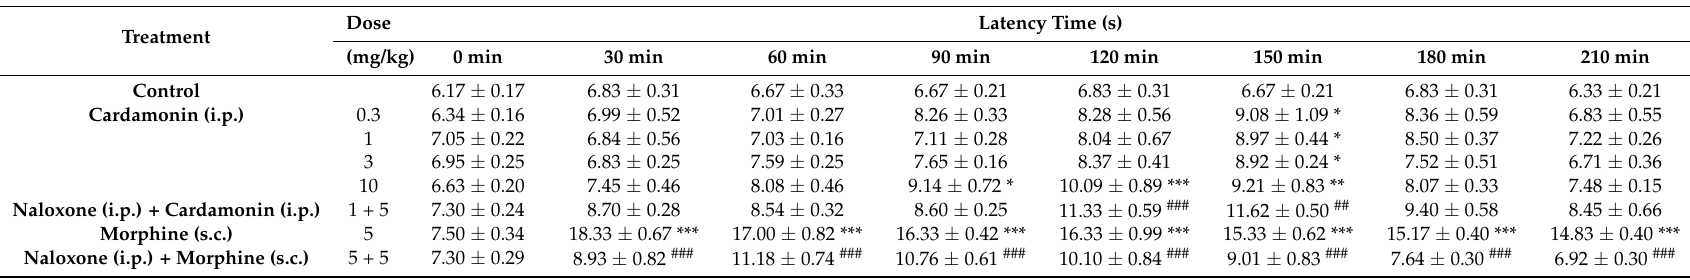
Table 1. Effect of cardamonin on the hot plate test in mice. Results were expressed in mean ± S.E.M of latency time (s) of 6 mice. Statistical significance was determined by two-way ANOVA followed by Bonferroni post hoc